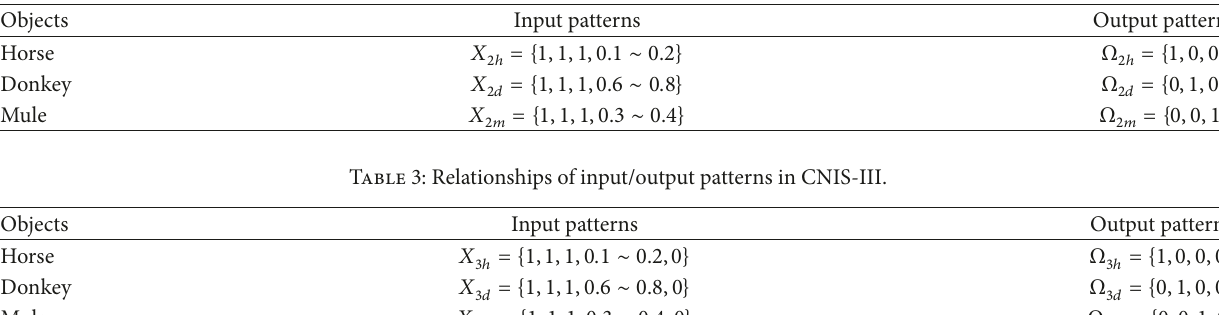
Table 2: Relationships of input/output patterns in CNIS-II.